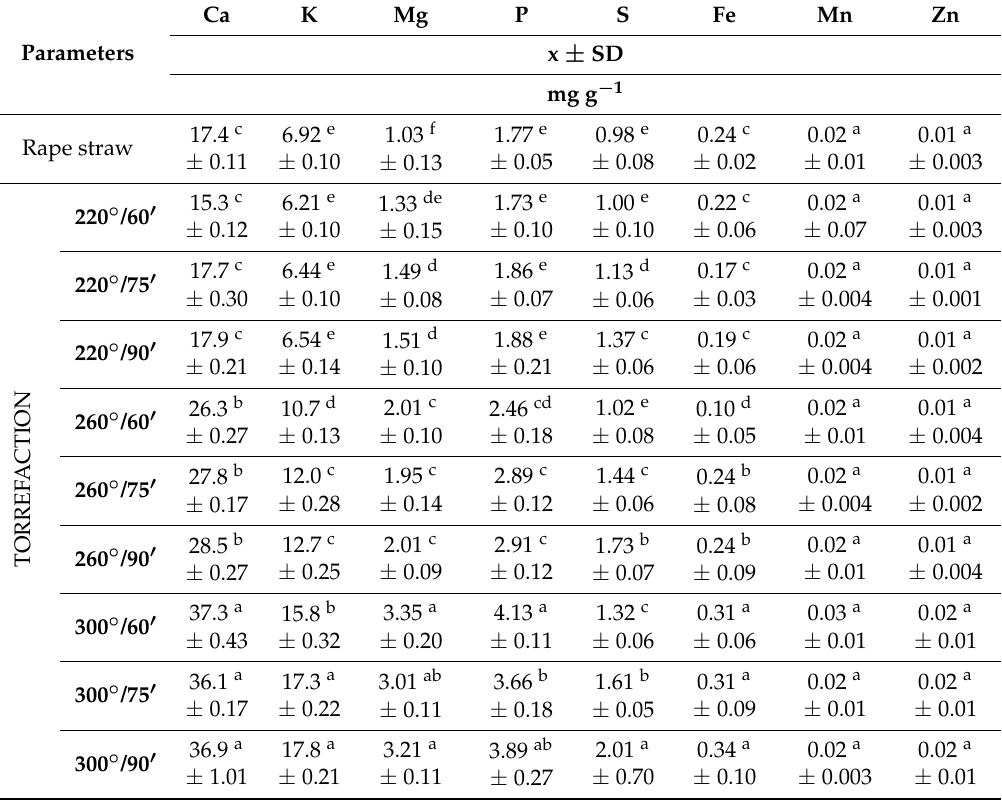
Table 5. The content of Ca, K, Mg, P, S, Fe, Mn, and Zn in rape straw and torrefied products.